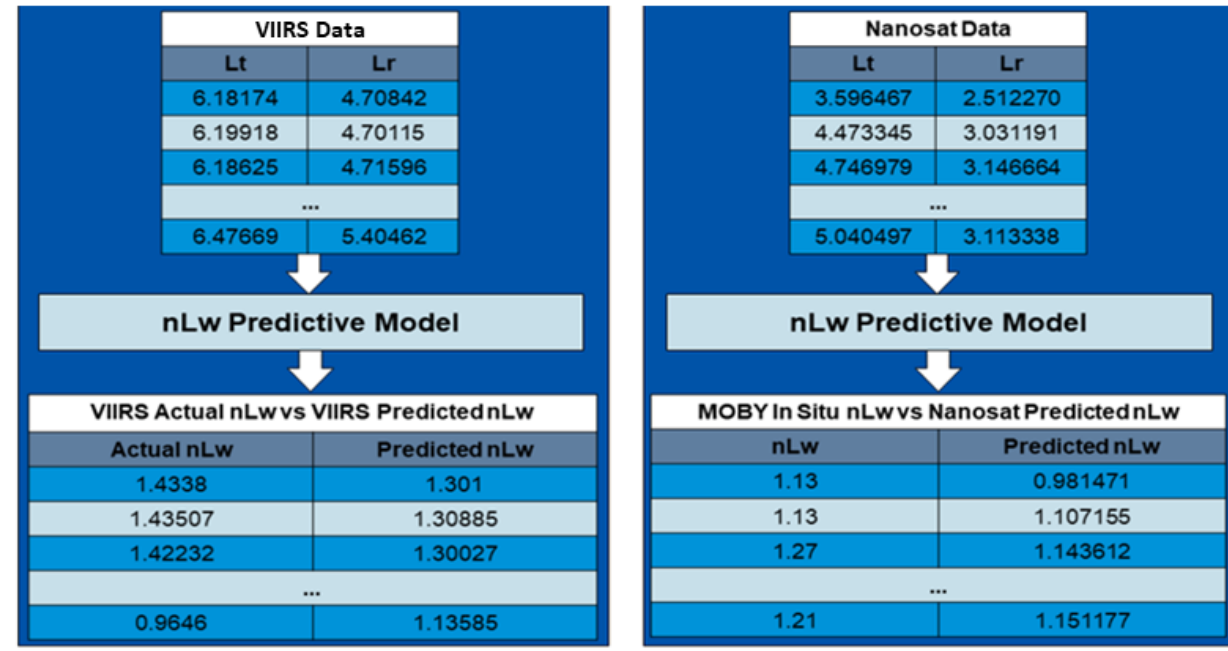
Figure 3. Complete methodology for building and validating a linear regression nLw predictive model at wavelength 486 nm from VIIRS training datasets at the MOBY nLw in situ mooring. Decision trees are a popular supervised learning method for a variety of reasons.